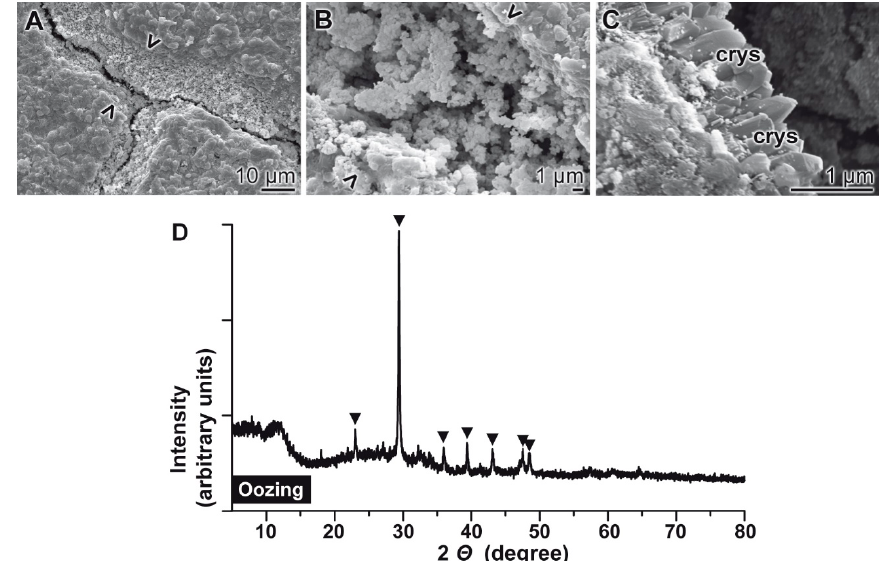
Figure 12. Microscopicanalysis(ESEM)ofthematerialoozedintocracksintroducedinto“hCEM • ACCP10” cement ( A–C ). Samples were treated as follows; 10-days aging / maturation—insertion of cracks—10 days post-incubation. The original borders of the cracks are marked ( > < ). ( D ) The grainy material formed within the cracks was scraped out of the healing site and analyzed by XRD. The signals characteristic for calcite are highlighted ( (cid:72) ). The crystals (crys) visible in ESEM can originate from calcite or from